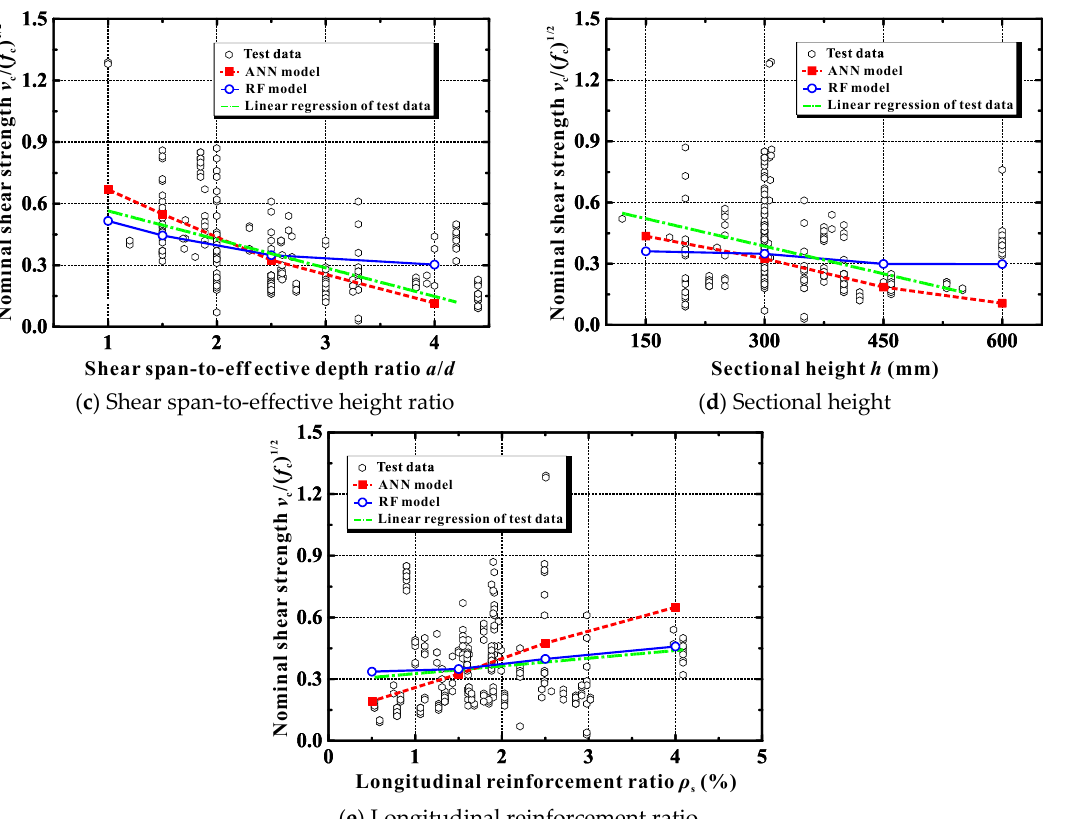
Figure 7. Effect of different parameters on the nominal ultimate shear stress. Figure 7. E ff ect of di ff erent parameters on the nominal ultimate shear